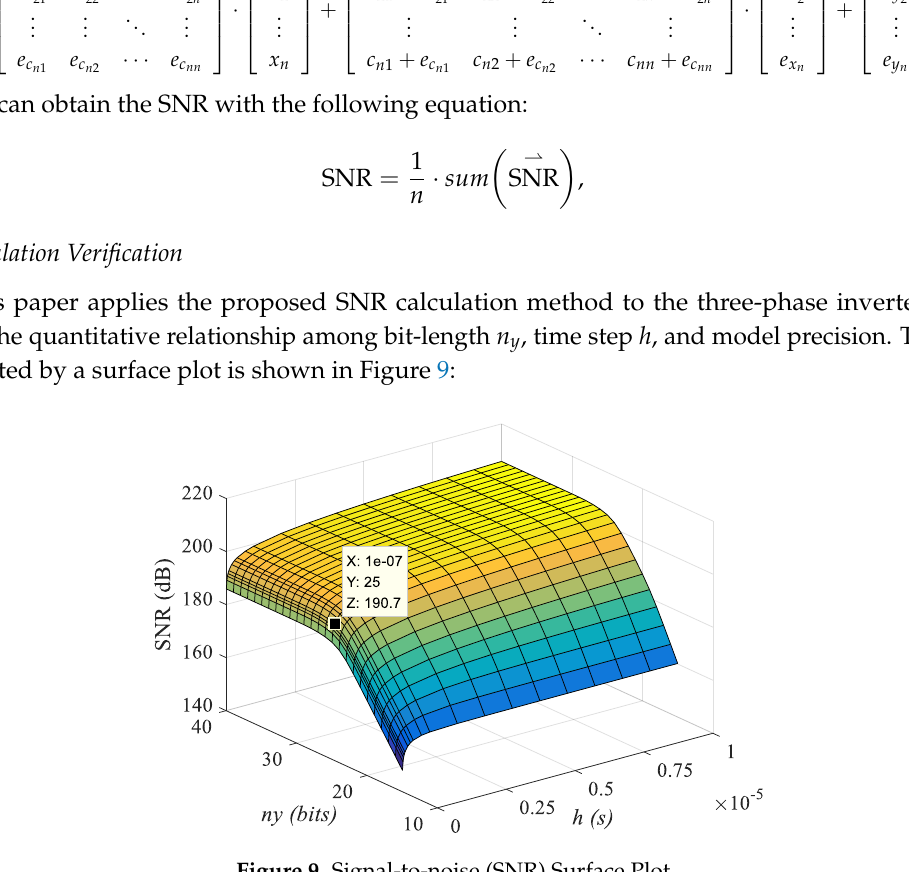
Figure 9. Signal-to-noise (SNR) Surface Plot.